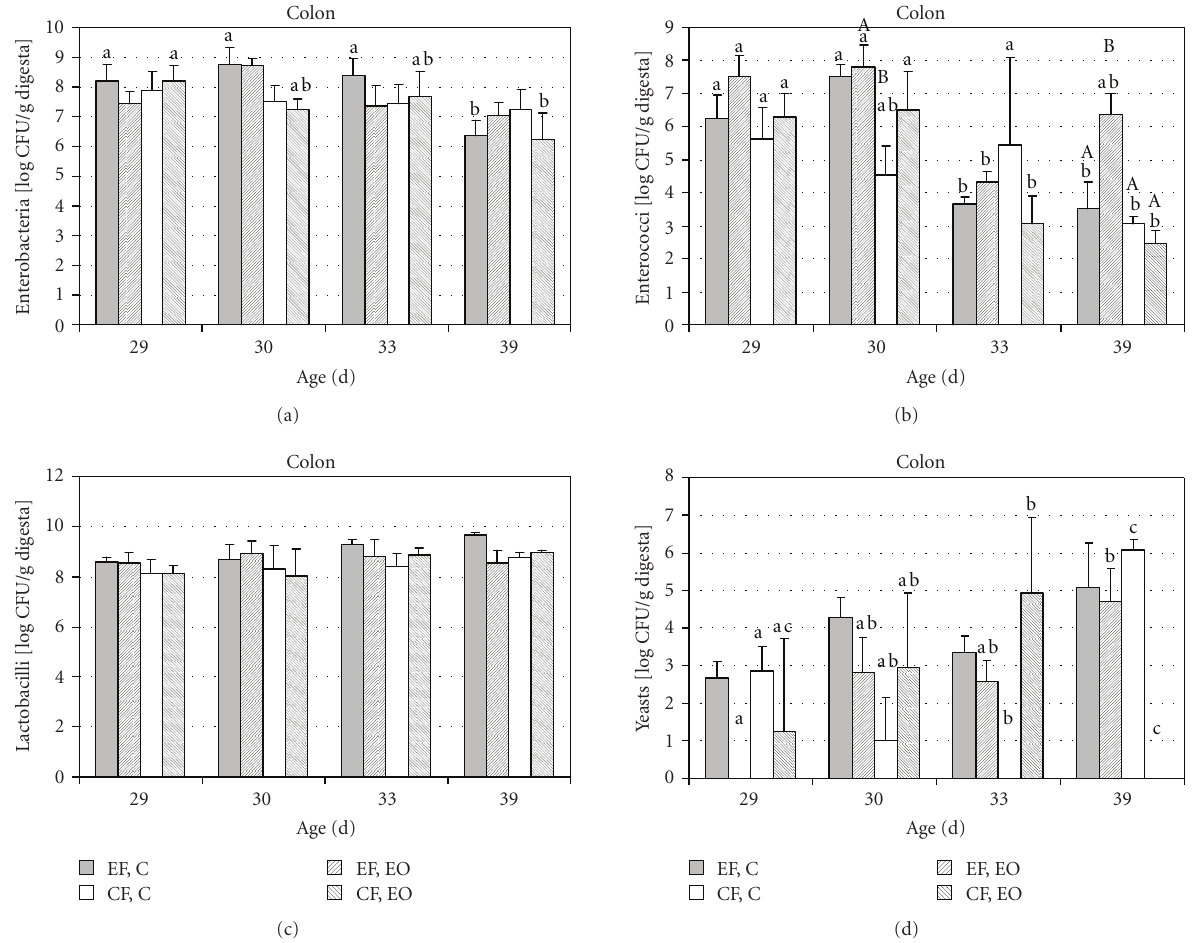
Figure 3: Bacterial groups and yeasts (log CFU/g) cultivated from colon digesta collected at 29, 30, 33, and 39 days of age from piglets fed after weaning (at 28 days) a starter diet (C) with 0.04% of essential oils mixture containing limonene, pinene, and eugenol. The piglets were reared either at an experimental (EF) of commercial farm (CF). The significant di ff erences ( P < . 05) between days within one group are marked with di ff erent small letters (a, b), and the di ff erences between groups on one day are marked with capital letters (A, B). For clarity, only columns that di ff er are